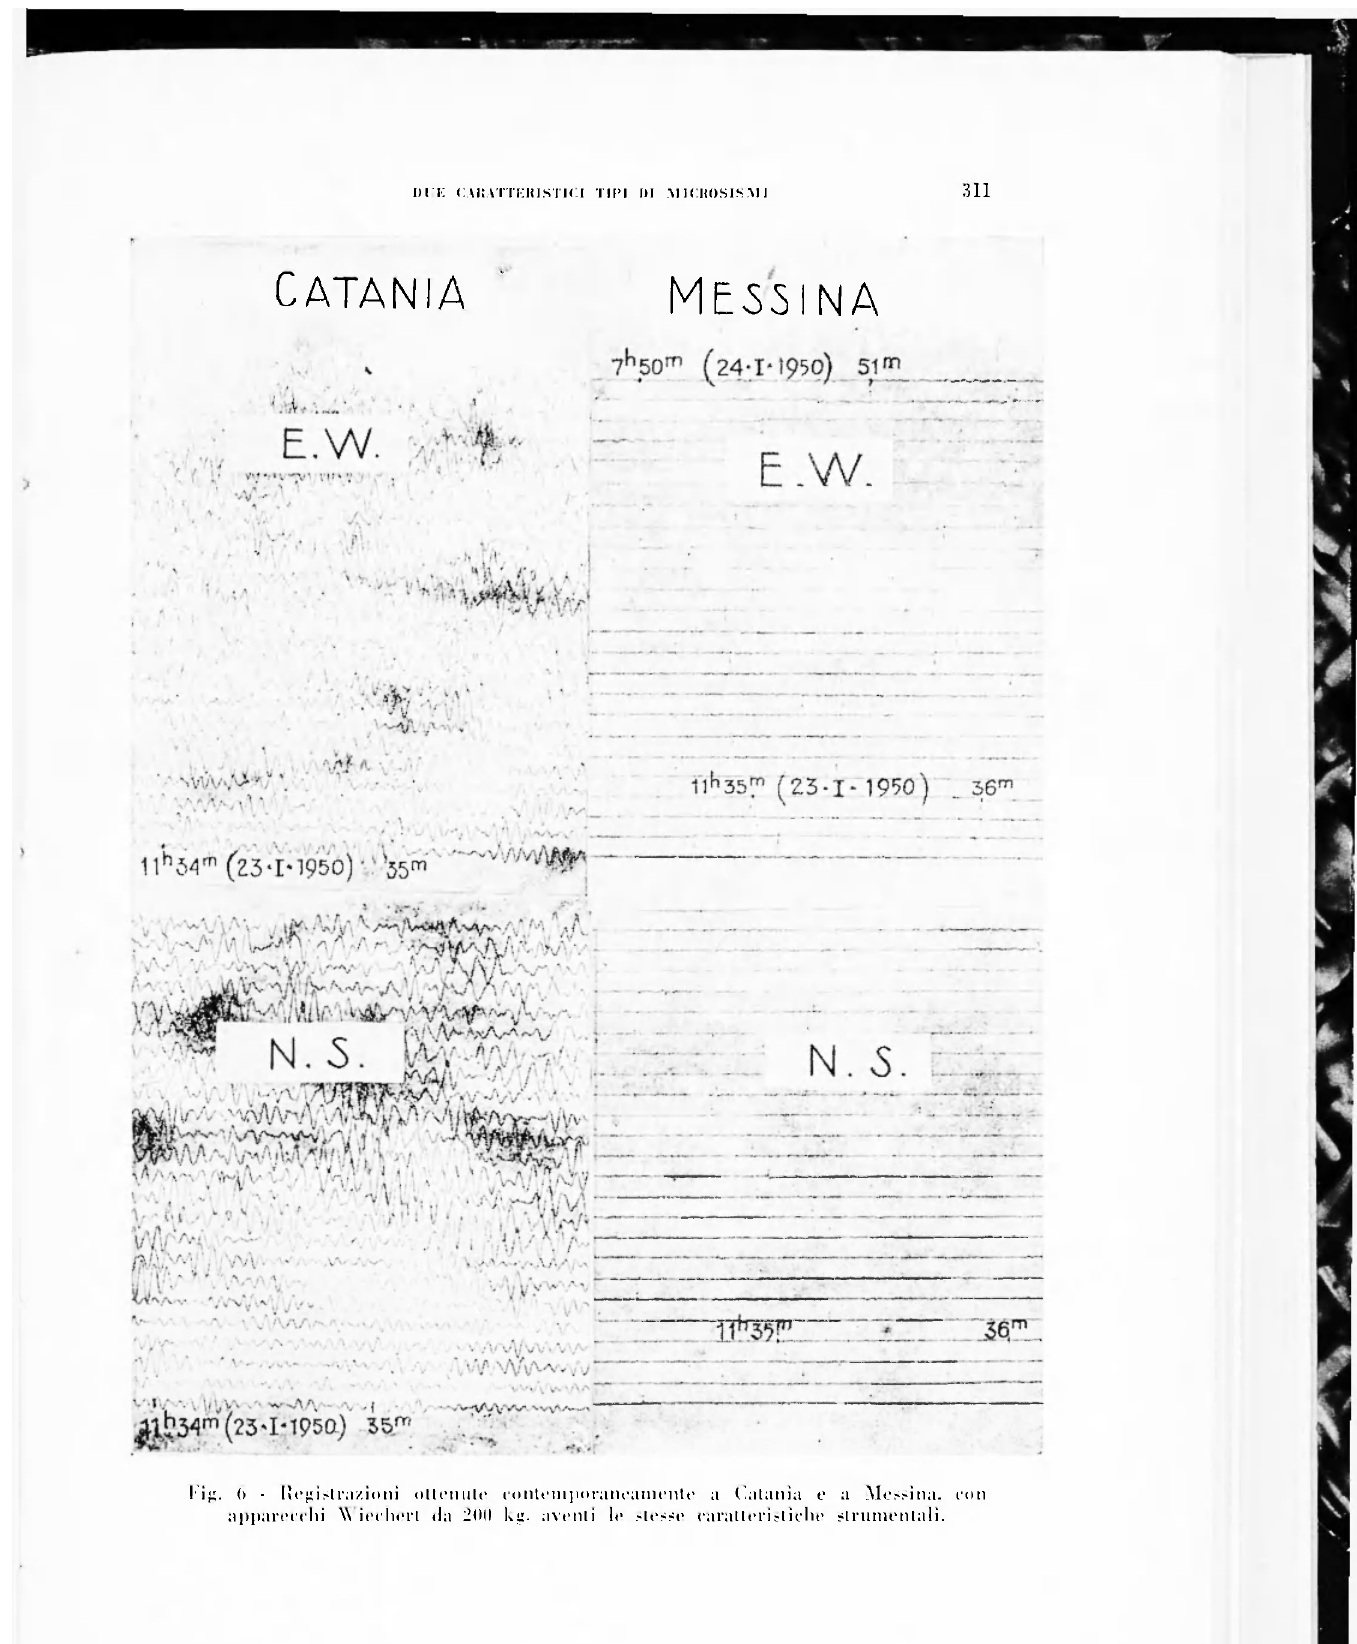
Fig. 6 - Registrazioni ottenute contemporaneamente a Catania e a Messina, con apparecchi Wiechert da 200 kg- aventi le stesse caratteristiche